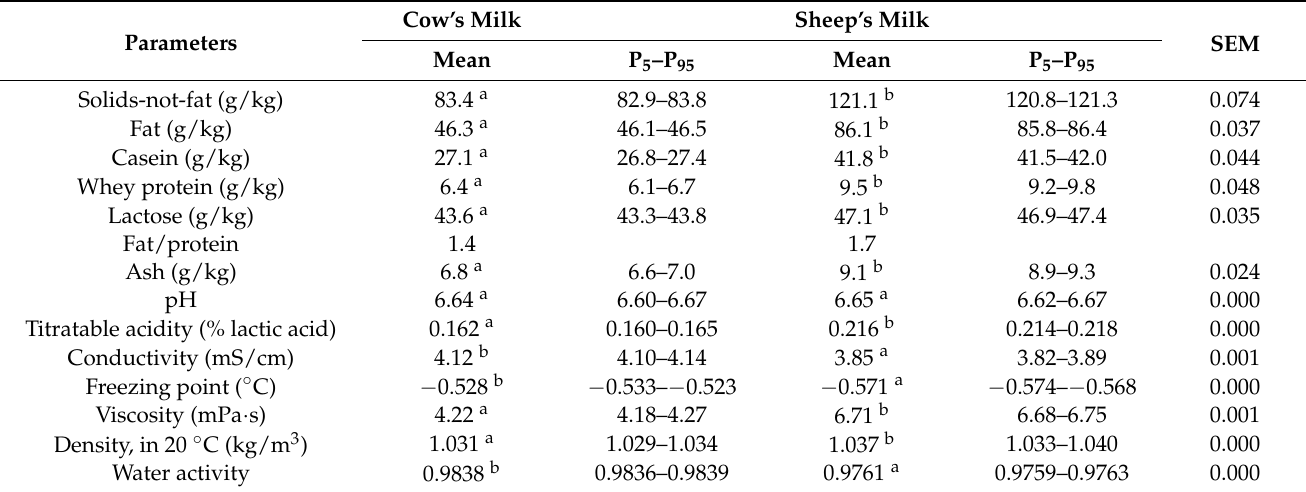
Table 1. Composition and technological parameters of raw cow’s and sheep’s milk.